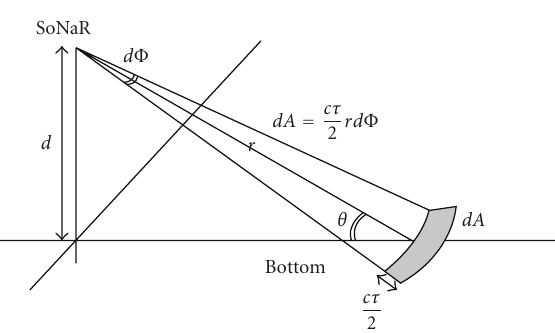
Figure 5: Definitions for surface reverberation modeling.